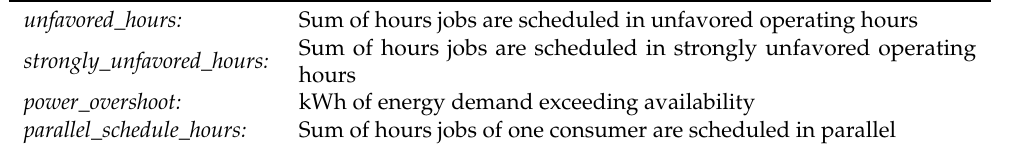
Table 3. Decision